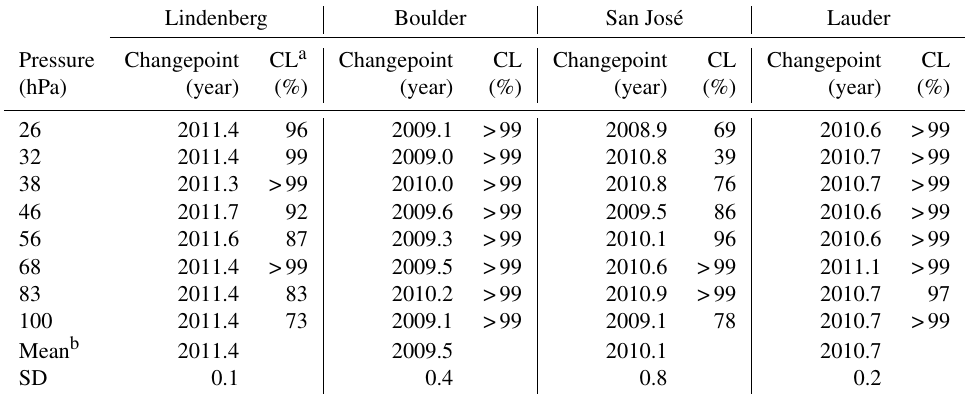
a Confidence levels for the listed changepoint dates, with >99 indicating a value between 99 and 100%. b Mean and standard deviation of the listed changepoint dates for each site.